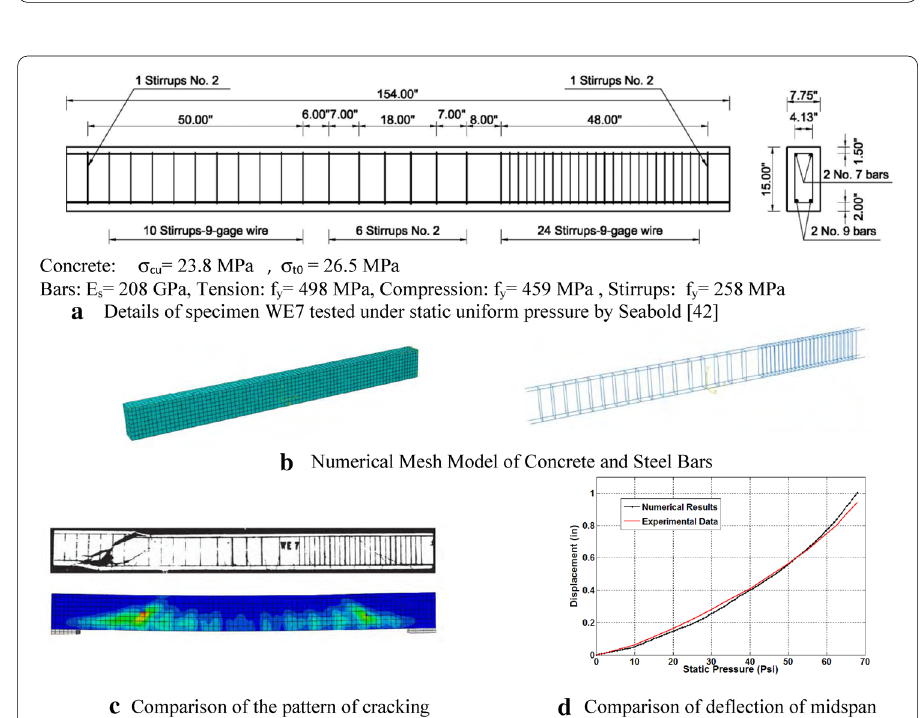
Fig. 7 RC beam details and comparisons between experimental and numerical